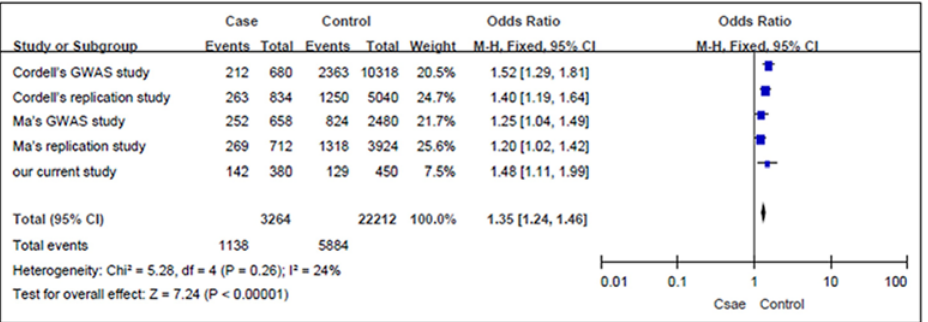
Fig 2. The results of meta-analysis of rs16835979 polymorphisms and ASD